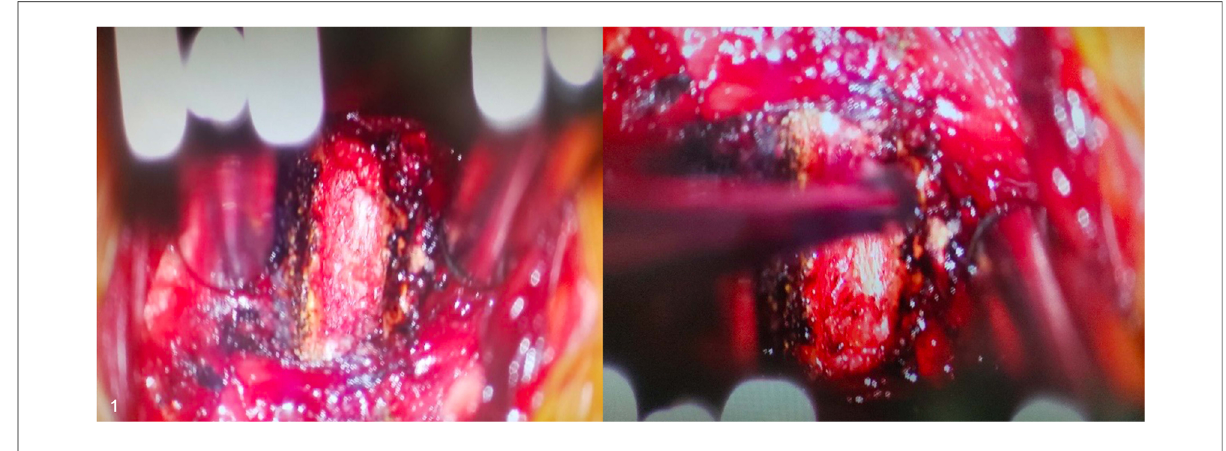
FIGURE 1 Intraoperative visualization of an ACDF procedure with the